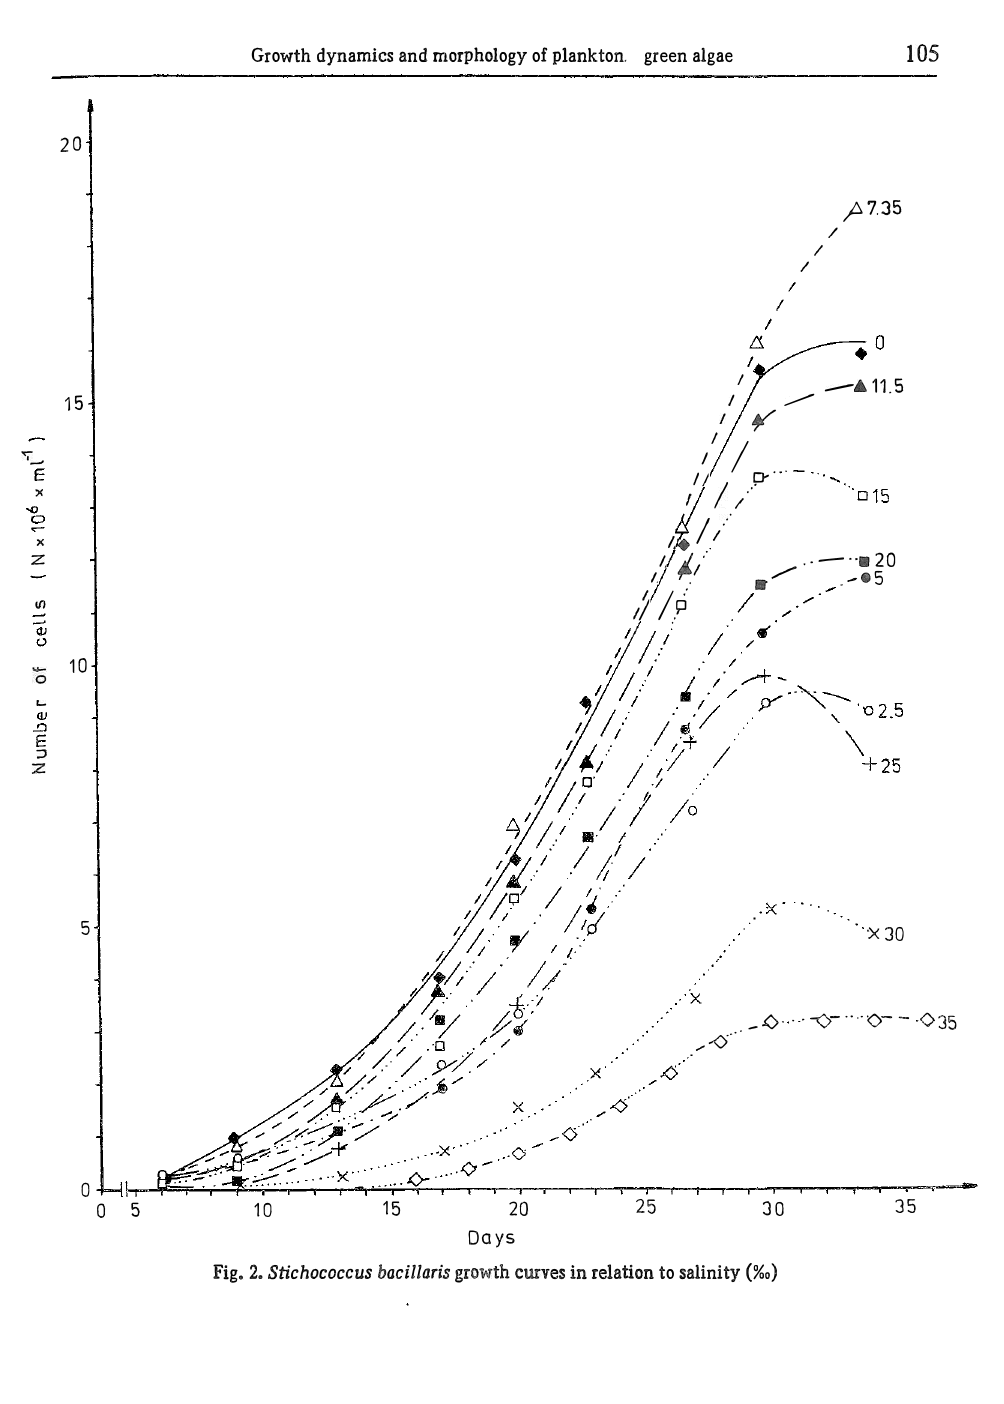
Fig. 2. Stichococcus bacillaris growth curves in relation to